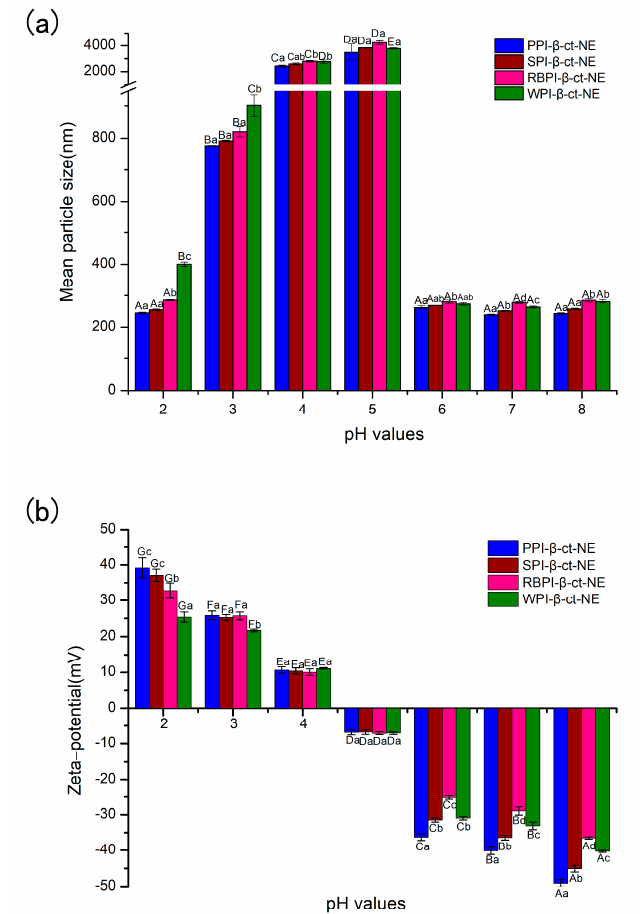
Figure 5. ( a ) Mean particle sizes of PPI-, SPI-, RBPI-, and WPI-stabilized nanoemulsions under different pH conditions; and ( b ) zeta potentials of the PPI-, SPI-, RBPI-, and WPI-stabilized nanoemulsions under different pH conditions. A–E represent statistically significant differences ( p < 0.05) under different pH conditions in the same sample. a–d represent statistically significant differences ( p < 0.05) between different samples under the same pH condition.